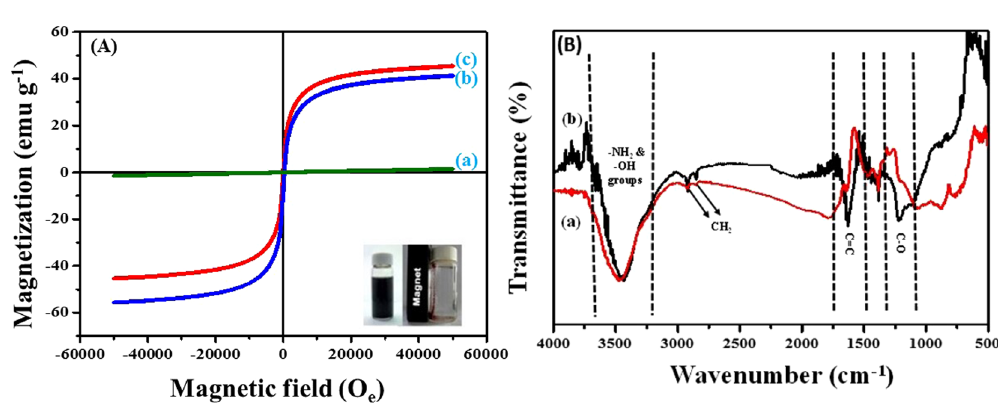
Figure 4. ( A ) Hysteresis (M-H) analysis of (a) porous graphene (PG), (b) porous graphene – CoFe 2 O 4 (PG-C) and (c) carbon nanofibers – CoFe 2 O 4 (CNF-C); ( B ) FT-IR analysis of (a) porous graphene – CoFe 2 O 4 (PG-C) and (b) carbon nanofibers – CoFe 2 O 4